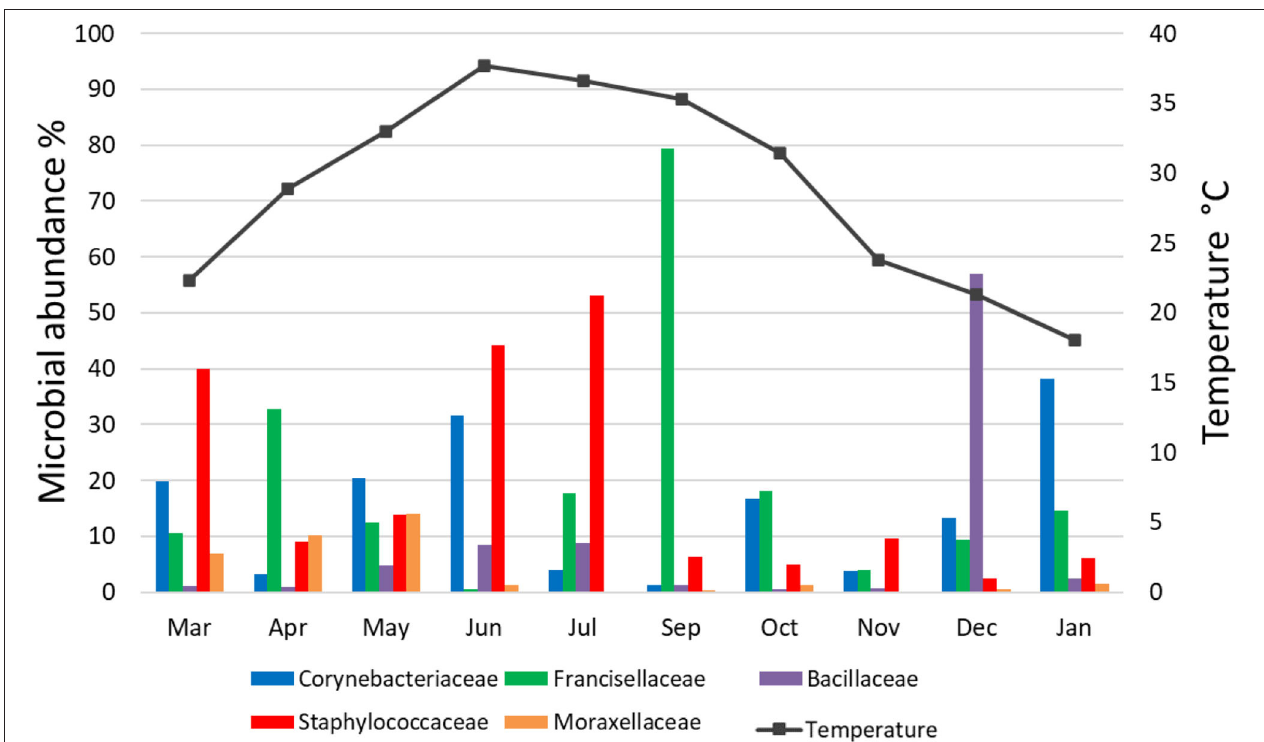
FIGURE 6 | Variation in the relative abundance of bacterial families in relation to temperature in H. dromedarii partially engorged female ticks throughout the